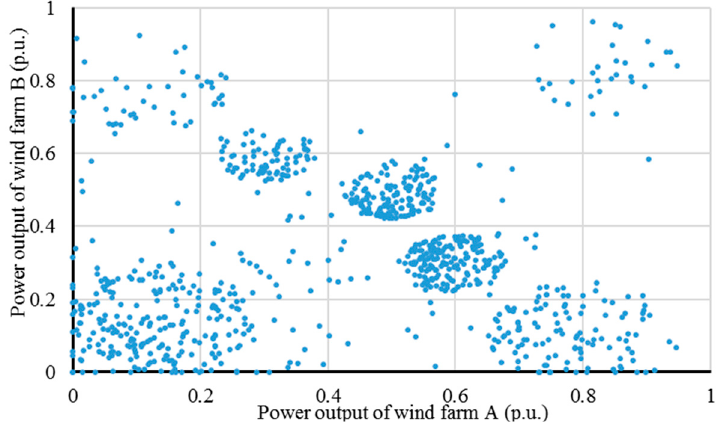
Figure 1. Scatter distribution of the wind power dataset.